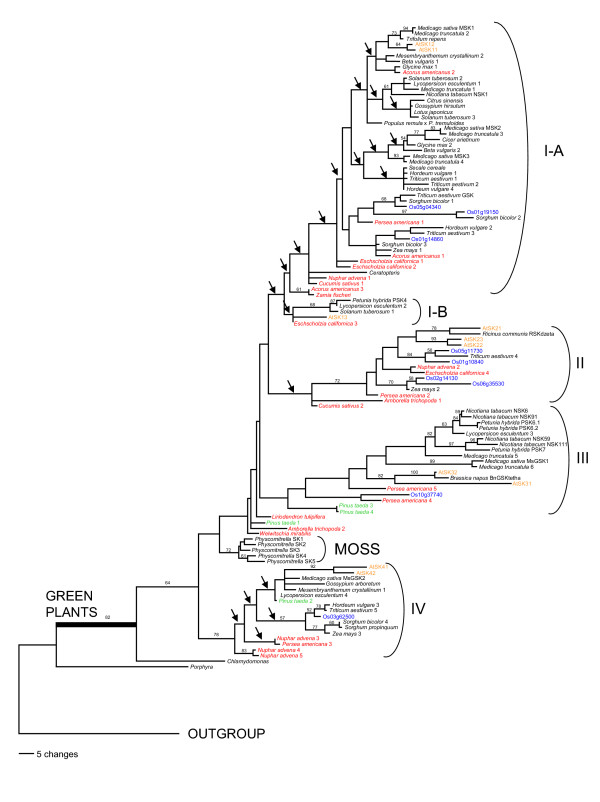
50% majority rule consensus tree of 77 most parsimonious trees (length = 2156; CI = 0.4935; RI = 0.7532) of GSK3/SHAGGY-like kinase proteins from plants, animals, protists, and fungi based on sequence alignment of the 348 amino acids of the catalytic domain and part of the C terminus. Numbers above the branches are bootstrap values; only values over 50% are indicated. Arrows on the nodes indicated the collapsed braches in the strict consensus tree. Orange labels indicate GSK proteins from Arabidopsis, and blue labels designate rice proteins. GSK proteins inferred from FGP ESTs are labeled in red, and those from Pinus ESTs are labeled in green.